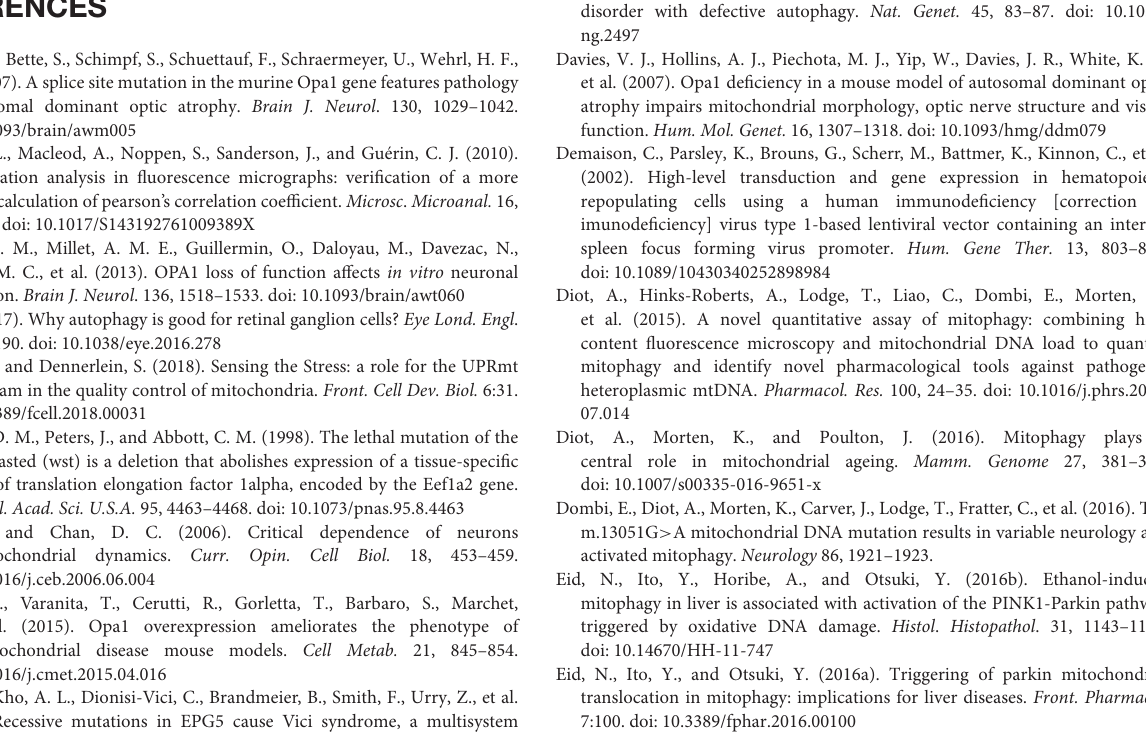
Figure S1 | Mapping of the mRFP transgene. The insertion of the mRFP transgene was investigated by paired-end sequencing. The insert is located in the 3rd exon of the pkn1 gene, which has been confirmed by PCR using a common forward primer (green) and two different reverse primers; one (red) 1,500bp from the forward primer in the wild type genome (blue) and one in the mRFP insert, approximately 800 bp from the forward primer. The 1,500 bp PCR only works in the wild type genome and the 800 bp only when the insert is present. Figure S2 | Analysis of OPA1 expression in the MEFs used. Protein extracts were prepared from wt, RedMIT-GFP-LC3 and RedMIT-GFP-LC3-OPA1 Q285STOP MEFs and analyzed on a 8% acrylamide gel. The OPA1 signal was detected using a rabbit anti-OPA1 antibody (abcam ab42364) and revealed using a polyclonal goat anti-rabbit secondary antibody (Dako P0448) coupled to an ECL detection kit (WESTAR Supernova HRP Detection Substrate, Geneflow K1-0068) according to the manufacturer’s instructions and imaged with G:BOX (Syngene). Figure S3 | Images from sections of brain and spleen from control, RedMIT/GFP-LC3, and OPA1 Q285STOP /RedMIT/GFP-LC3. Brain (Bottom) and spleen (Top) from non-fluorescent (control), RedMIT/GFP-LC3 and OPA1 Q285STOP /RedMIT/GFP-LC3 mice were sectioned (10 µ m) and imaged on a Zeiss LSM 700 inverted confocal microscope with a plan-Apo 63x NA 1.4 oil-immersion objective. The fluorescent signals, GFP-LC3 and mitochondrial mRFP, are visible but no clear colocalization between them could be visualized in the views shown. High throughput imaging identified infrequent colocalization that was more marked in OPA1 Q285STOP /RedMIT/GFP-LC3 mice than RedMIT/GFP-LC3 mice ( Figure 5 ). Scale bars = 10 µ m. Table S1 | mRFP and GFP transgenes do not affect mice reproductive